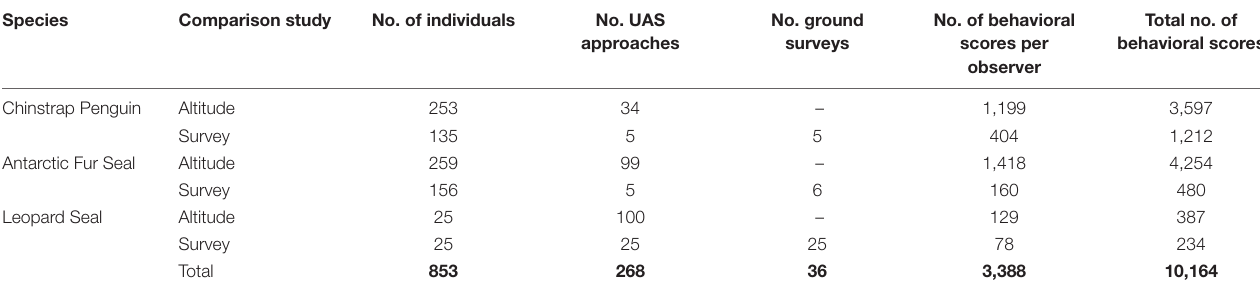
TABLE 4 | Numbers of flights, ground surveys, and individual animals scored by independent observers for behavioral reaction to unoccupied aerial systems (UAS) approach listed by species and study.